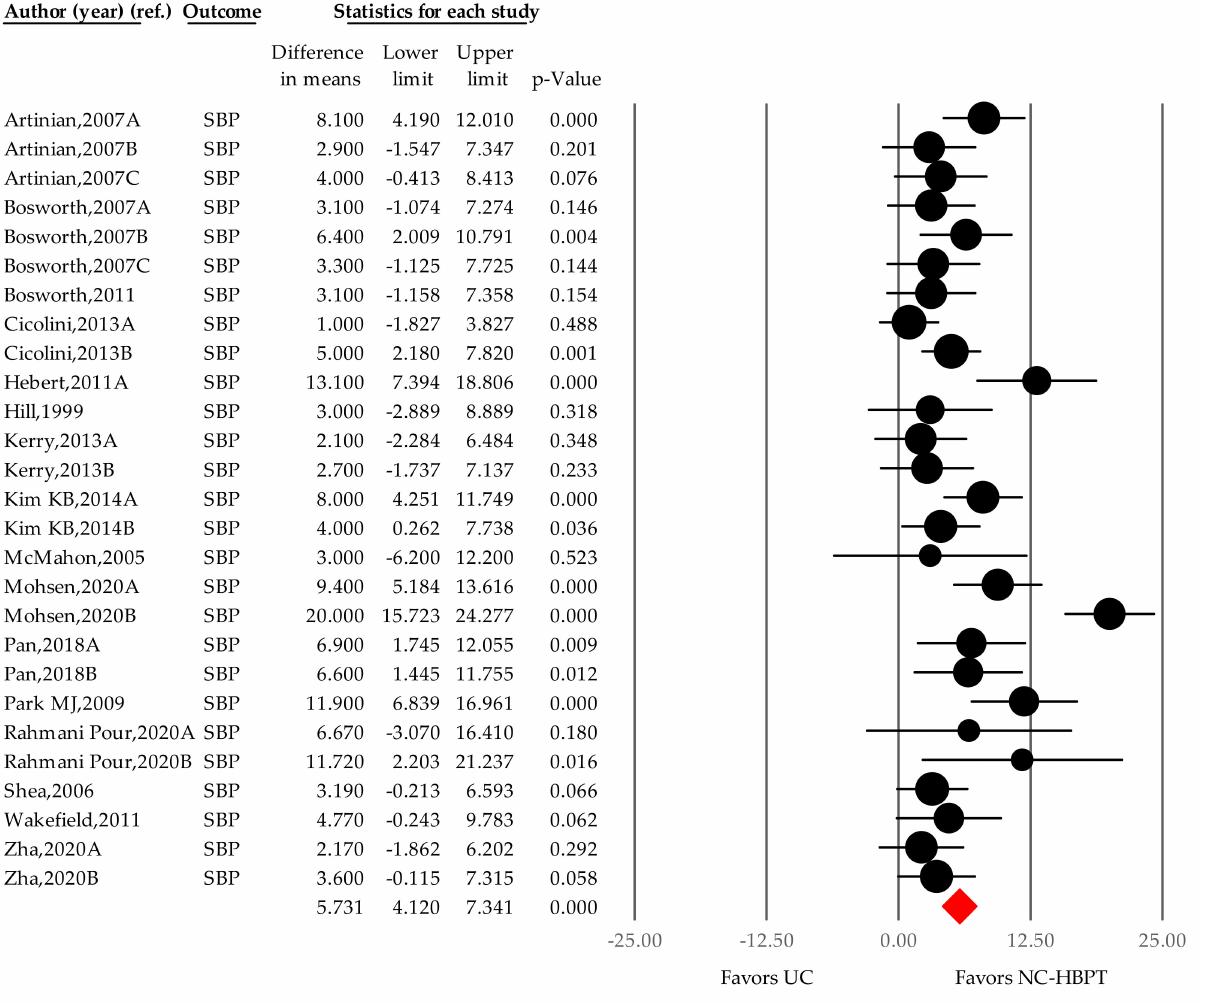
Figure 5. Difference in means of office systolic blood pressure changes by nurse-coordinated intervention. Notes. Point Figure 6. Difference in means of office systolic blood pressure changes over time. Notes. Point estimate of individual study estimate of individual study ( • ); Summary effect size ( ( ● ); Subgroup ( ○ ); Summary effect size ( ◆ ); DBP, diastolic blood pressure; UC, usual care; NC-HBPT, nurse-coordinated home blood pressure